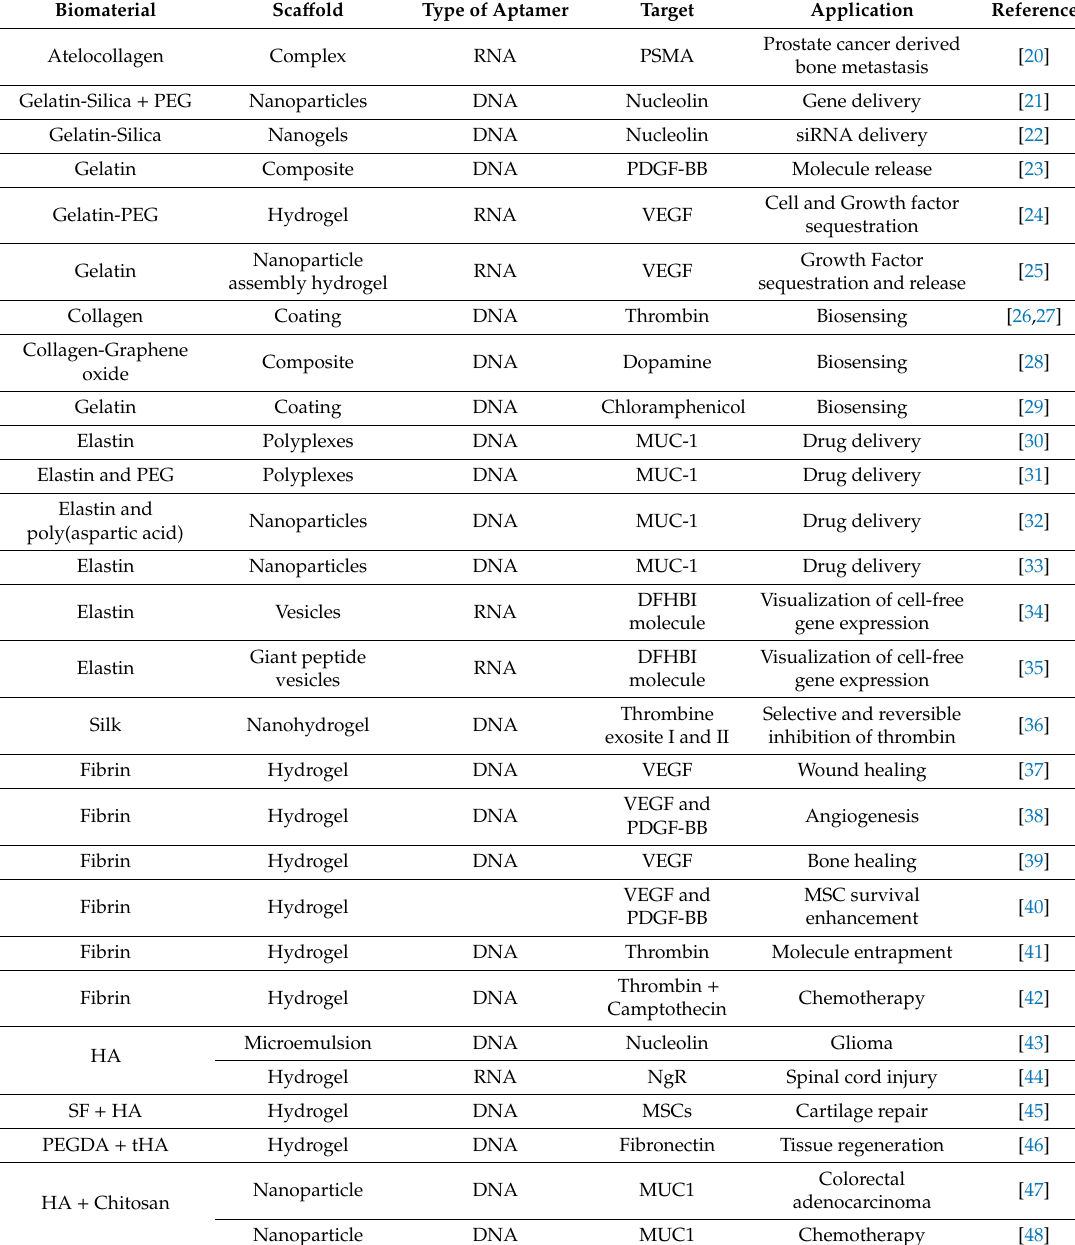
Table 1. A summary of di ff erent types of aptamer-targeted biomedical systems described in this review.